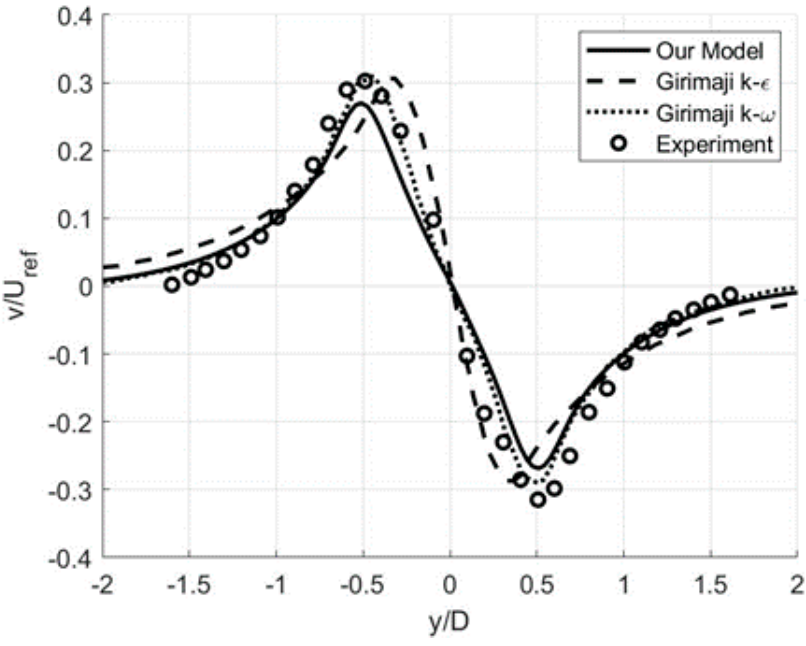
Figure 21. The mean vertical velocity profile at x / D = 1 ( f ε = 1.0, f k = 0.5 ) .